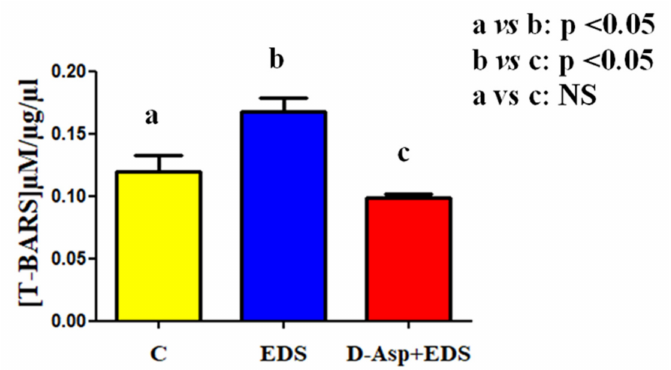
Figure 5. Lipid peroxidation evaluated by thiobarbituric acid-reactive species (TBARS) assay. Oxida- tive stress status evaluated via TBARS assay in testicular samples from control, EDS, and D-Asp + EDS treated rats. Values are expressed as means ± SEM from 5 animals in each